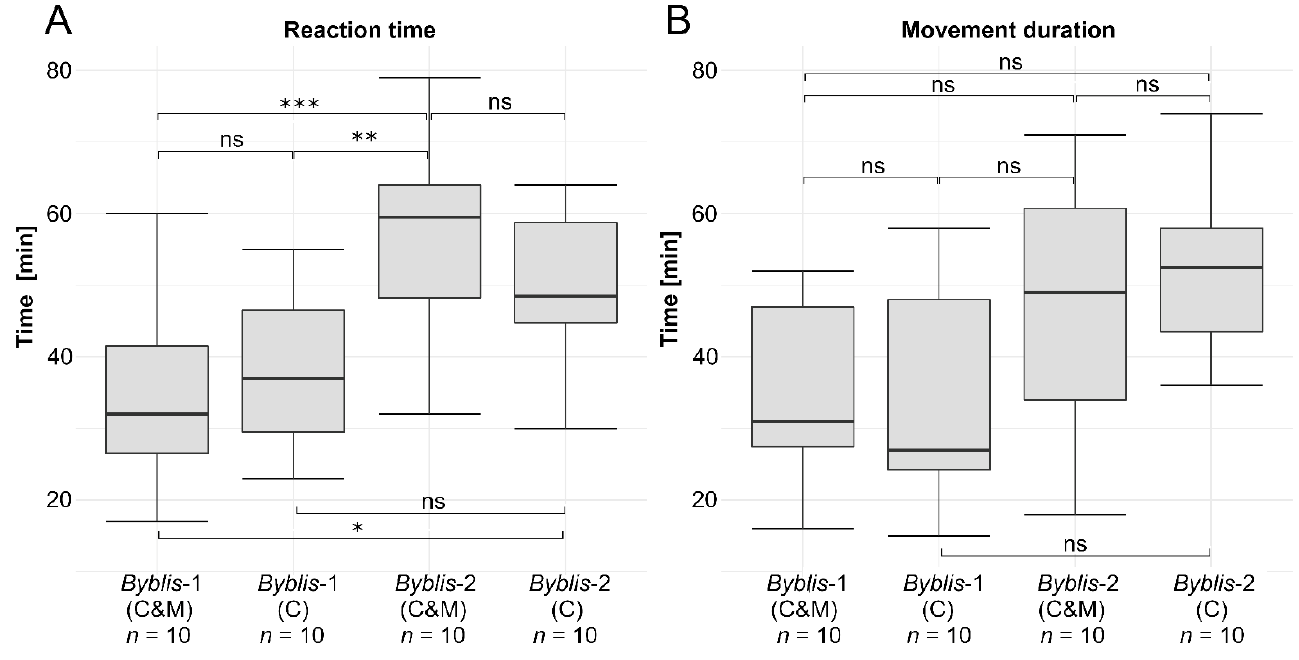
Figure 3. Stalked gland reaction time ( A ) and movement duration ( B ) measured on leaves from two B. gigantea plants ( Byblis -1, Byblis -2) and grouped according to the respective stimulation scenarios: pure chemical (C) and combined chemical and mechanical stimulation (C&M). The asterisks indicate the significance levels ( * ≙ 0.01 ≤ p < 0.05; ** ≙ 0.001 ≤ p < 0.01; *** ≙ p < 0.001; ns ≙ not significant). The sample sizes ( n ) are indicated.